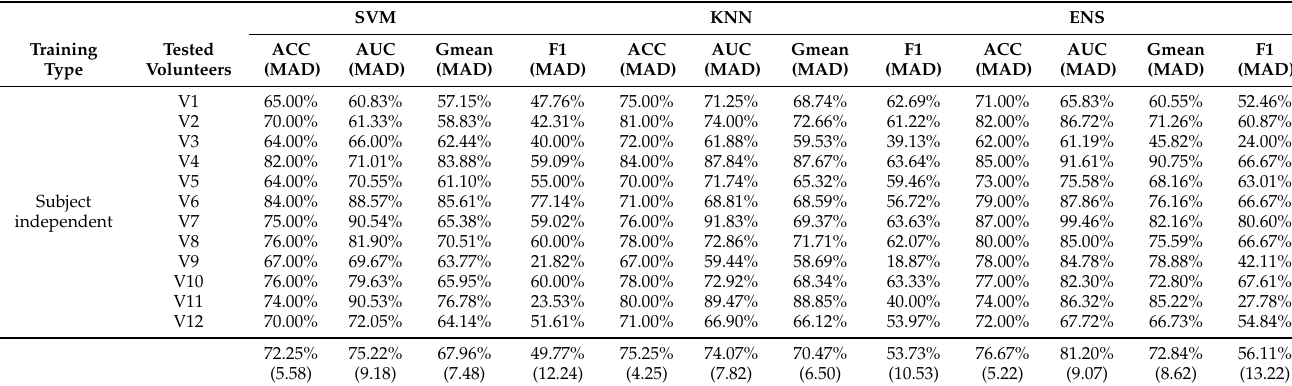
Table 3. Performance metrics for each generated subject-independent model and average performance metrics and dispersion for each classification algorithm. The training stage is performed using all the volunteers except the tested volunteer in each model generated (unseen test